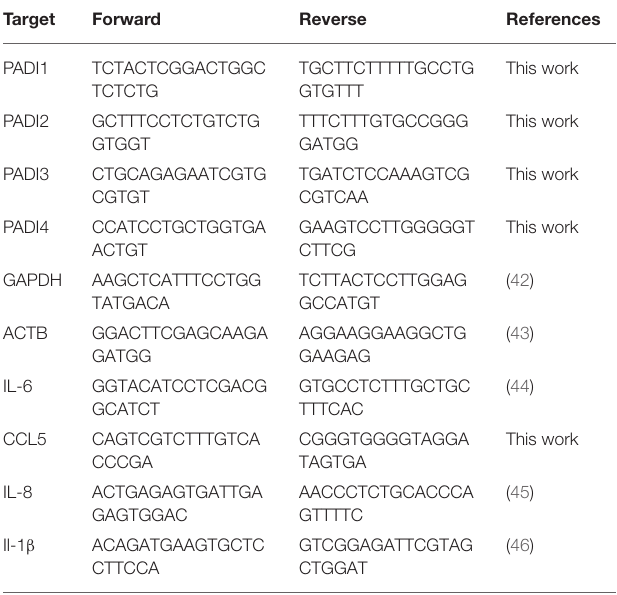
TABLE 2 | qPCR Primer sequences utilized in this